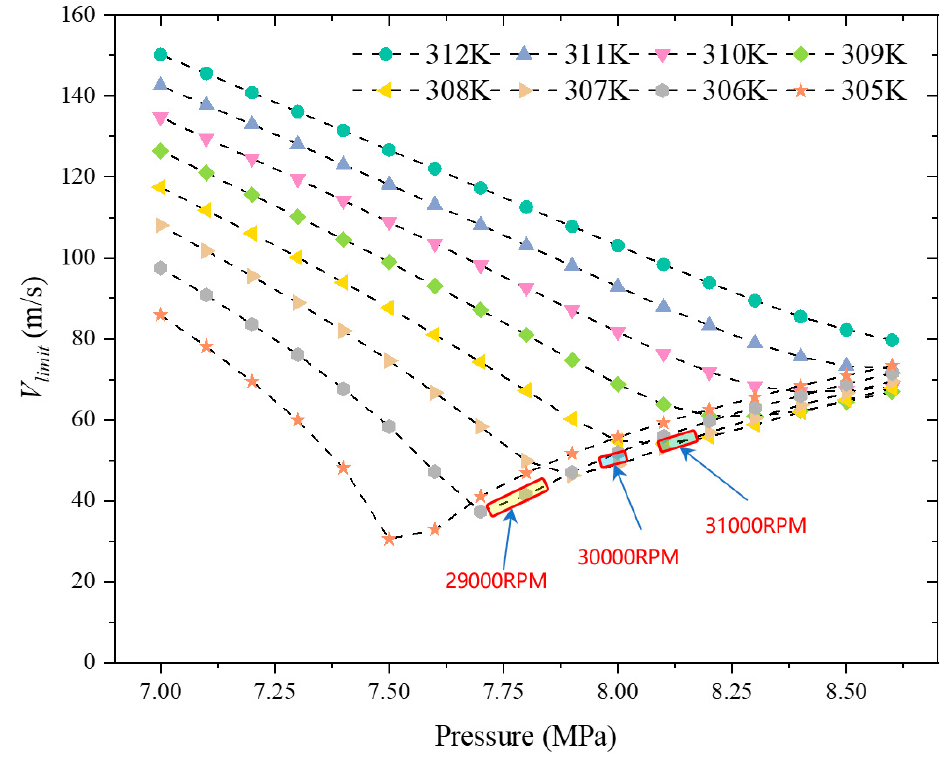
Figure 17. The condensation acceleration velocity of inlet condition (@ 31,000 ± 1000 RPM).